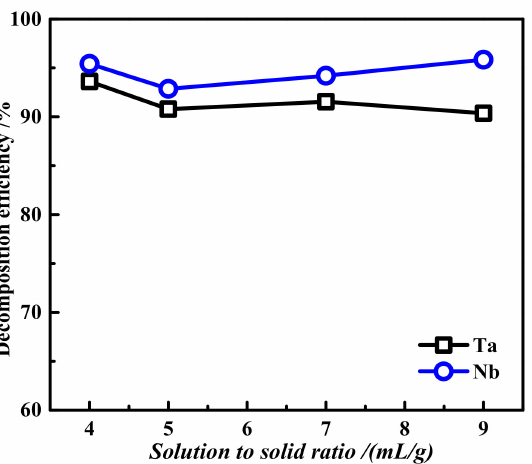
Figure 7. Effect of different liquid–solid ratios on the decomposition efficiencies of tantalum and niobium: decomposition time 2 h, oxygen partial pressure 2.5 MPa, basicity 40 wt.%, and reaction temperature 200 ◦ C.